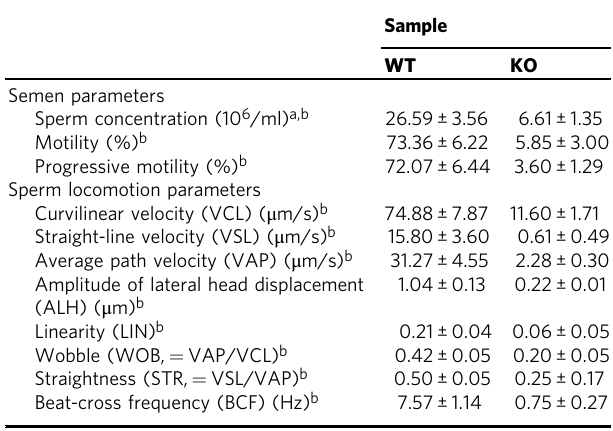
Table 2 Semen analysis in wild-type (WT) and knock-out (KO) male mice by